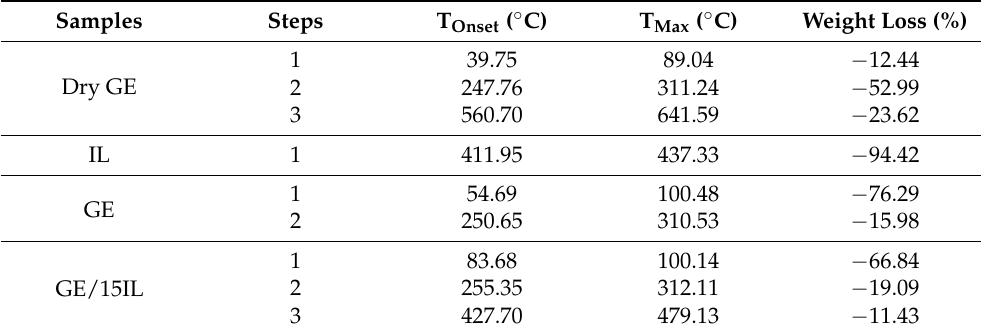
Table 5. Values were obtained from TGA and DTGA analyses of Dry GE, GE, GE/15IL and IL. Onset temperatures, Tonset; maximum temperatures, Tmax; and weight loss (%) at ◦ C/min. Samples